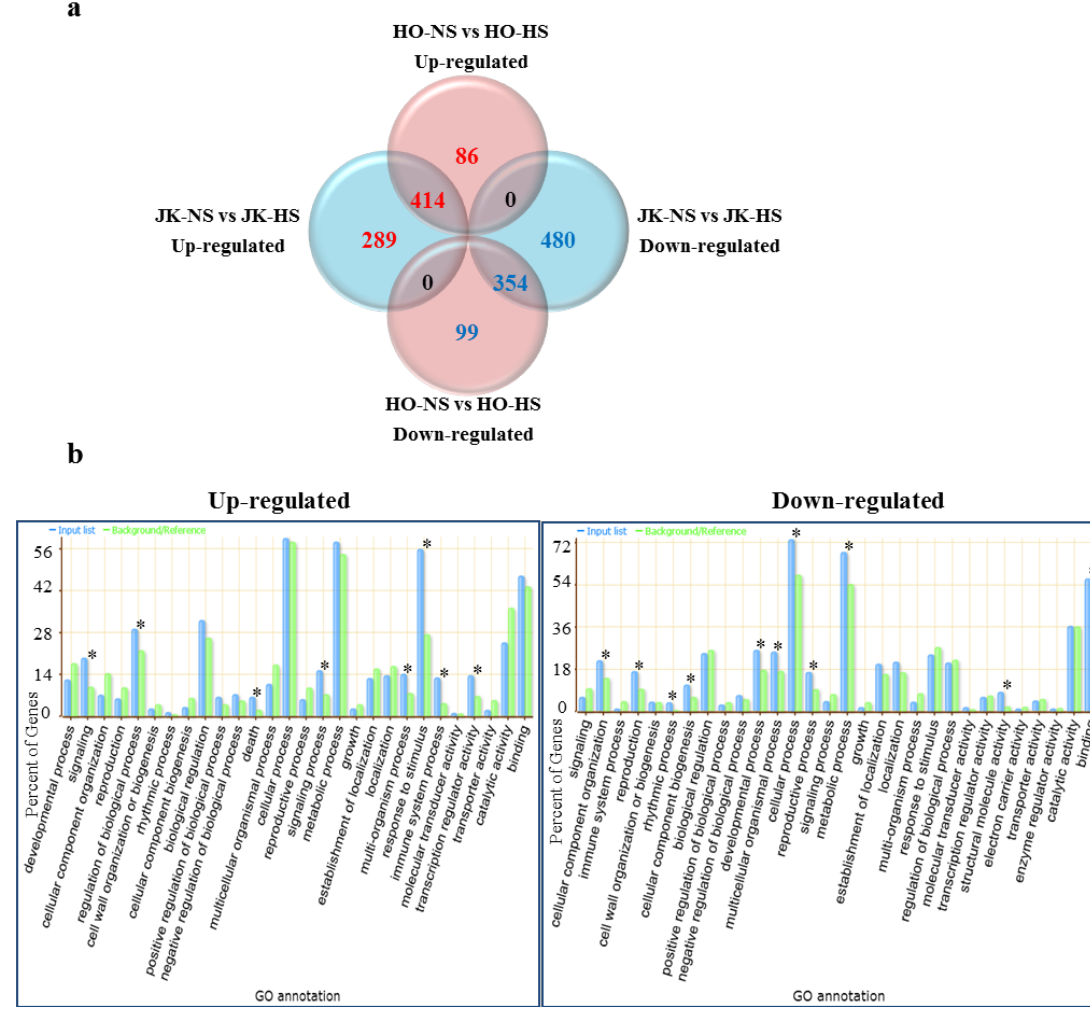
Figure 2. Microarray analysis of transcripts that are differentially expressed between heat stress-tolerant and heat-sensitive cabbage inbred lines exposed to heat stress. ( a ) Venn diagram showing differentially expressed transcripts of the two cabbage lines in response to heat stress and no heat stress conditions. HO-NS, heat stress-tolerant cabbage ―HO‖ inbred line—no heat stress; HO-HS, heat stress-tolerant cabbage ―HO‖ inbred line—heat stress; JK-NS, heat stress-sensitive cabbage ―JK‖ inbred line—no heat stress; JK-HS, heat stress-sensitive cabbage ―JK‖ inbred line—heat stress. The numbers of upregulated genes are shown in red, whereas the numbers of downregulated genes are shown in blue (fold change ≥2 and ≤−2, p ≤ 0.05); ( b ) Functional analysis of differentially expressed transcripts during heat stress or no heat stress in two cabbage lines. This chart shows GO terms for biological processes and molecular functions for 414 upregulated genes and 354 downregulated genes in tolerant and sensitive cabbages (fold change ≥2 and ≤−2, p ≤ 0.05). * Over-represented GO terms in the